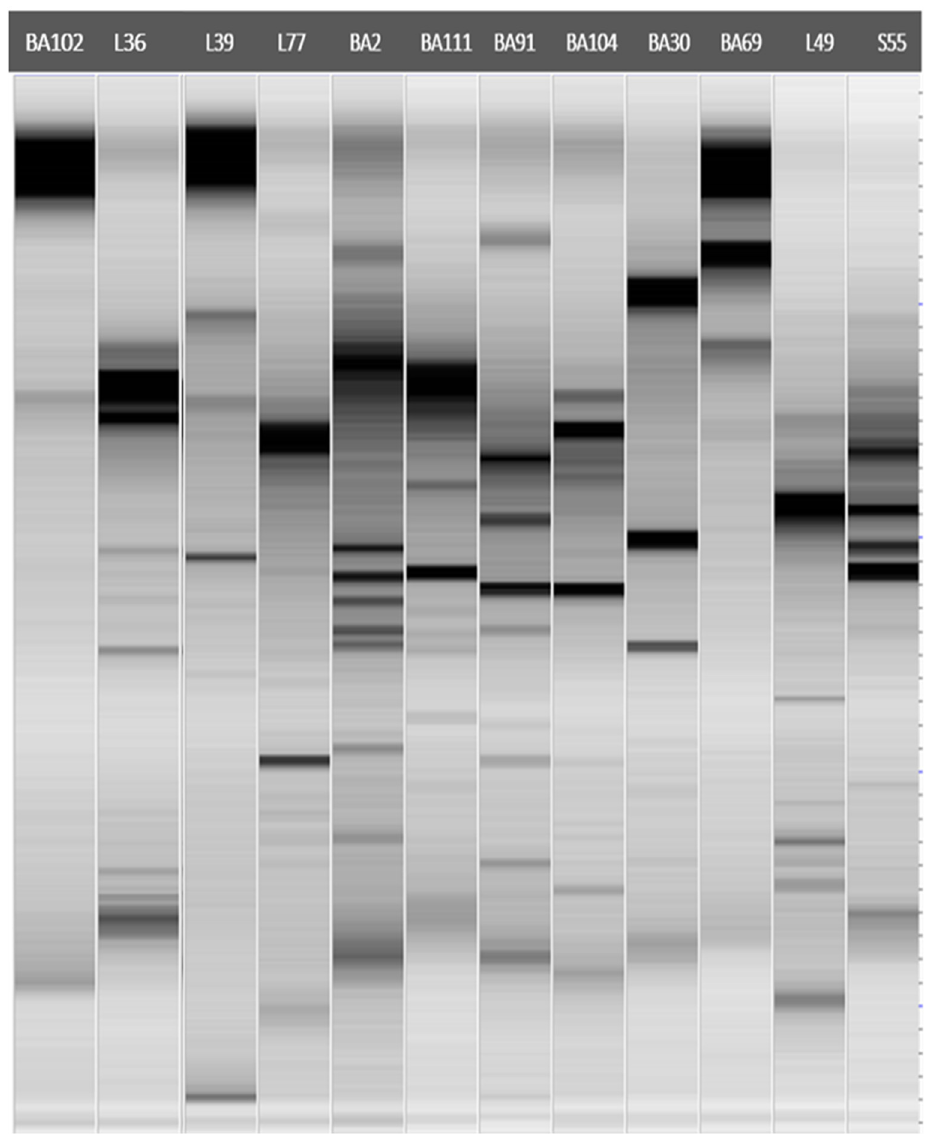
Figure 2. Gel-like image of ERIC-PCR profiles of endophytic bacteria isolated from olive plants and epiphytic bacteria isolated from different host plants (Table